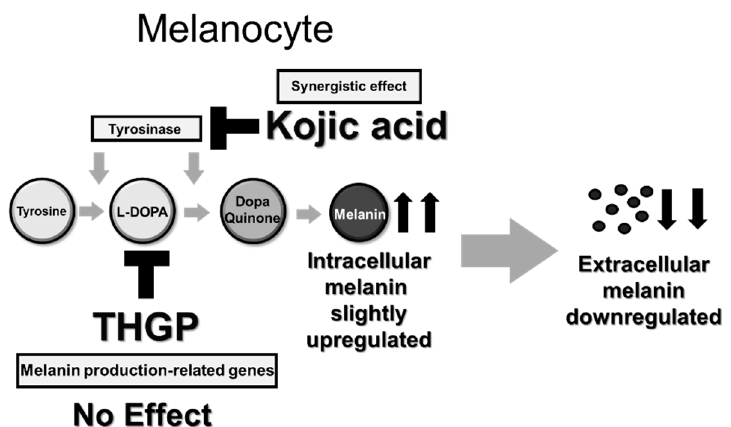
Figure 7. Mechanism underlying the inhibitory e ff ect of the combination of THGP and kojic acid on melanin synthesis. Compared with the control condition, THGP administration inhibits the amount of extracellular melanin but slightly increases the amount of intracellular melanin. In addition, THGP does not a ff ect tyrosinase activity or the expression of melanin production-related genes. Moreover, THGP shows a synergetic e ff ect with kojic acid. “up arrow” means up-regulated, “down arrow” means down-regulated, “grey arrow” means reaction path about melanin syhthesis and “T arrow” means inhibitory e ff